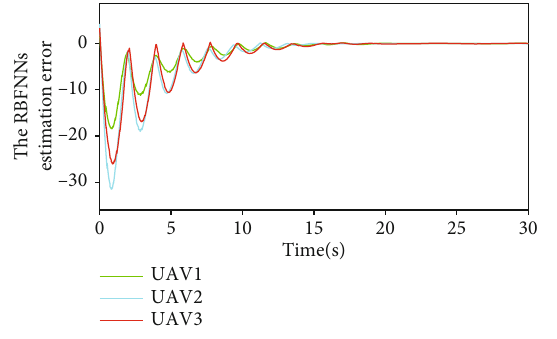
Figure 12: The RBFNN estimation error k ε